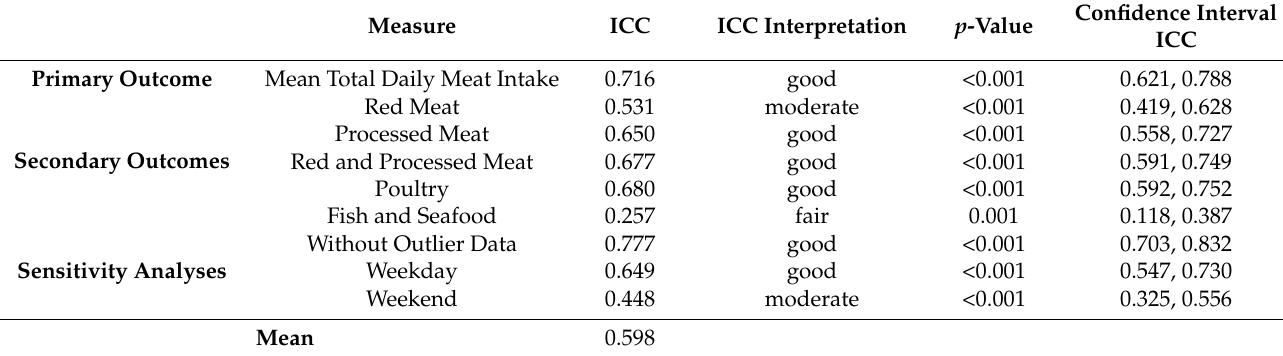
Confidence Interval